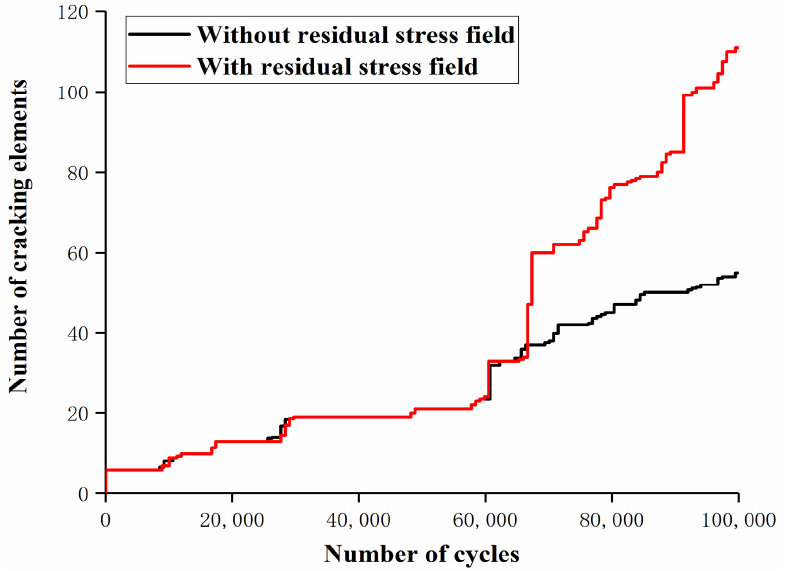
Figure 19. Relationship between the number of cracked elements and number of load cycles for with a maximum displacement load of 0.3 mm.